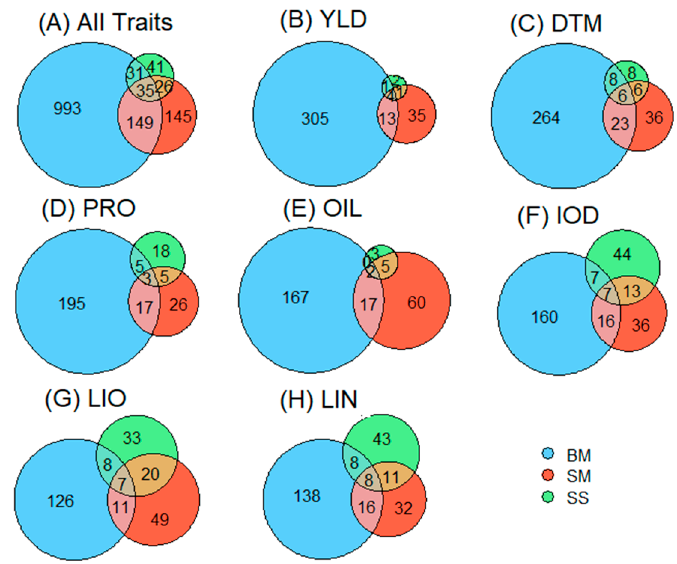
Figure 4. Venn diagrams of quantitative trait loci (QTL) identified by three types of genome-wide association study (GWAS) models for all seven traits ( A ) and individual traits ( B – H ). SS, SNP-based single-locus models; SM, SNP-based multi-locus models; BM, haplotype-block-based multi-locus model. YLD, seed yield; DTM, days to maturity; PRO, protein content; OIL, oil content; IOD, iodine value; LIO, linoleic acid content; LIN, linolenic acid content; SNP, single nucleotide polimorphsm.